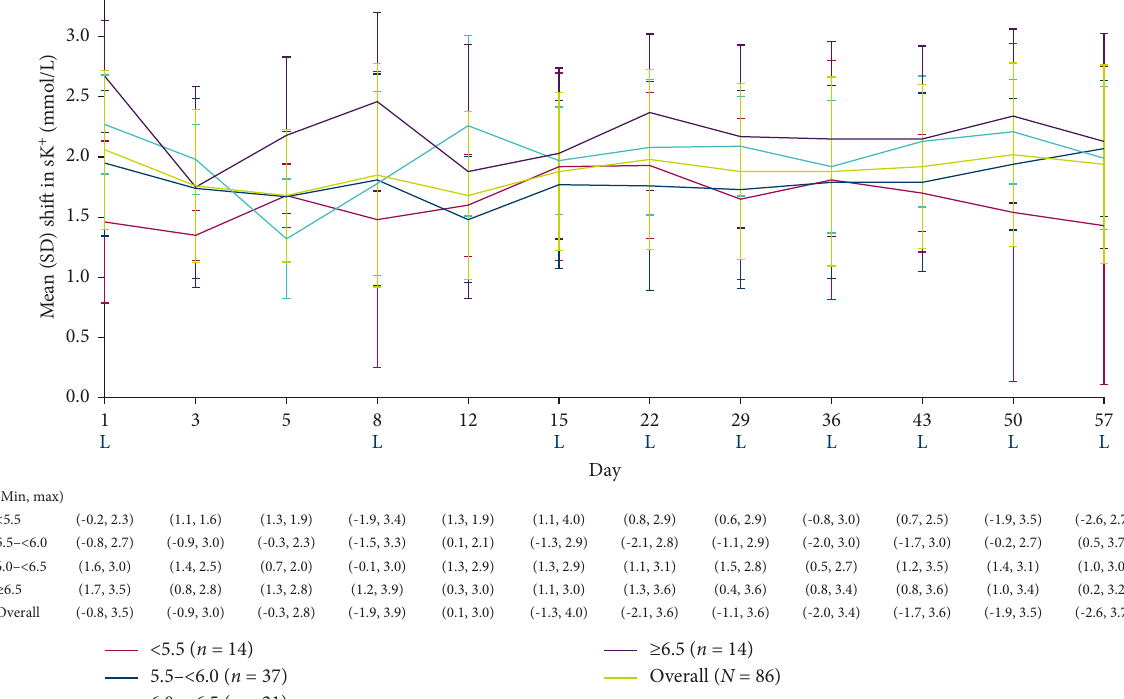
predialysis (cid:31)